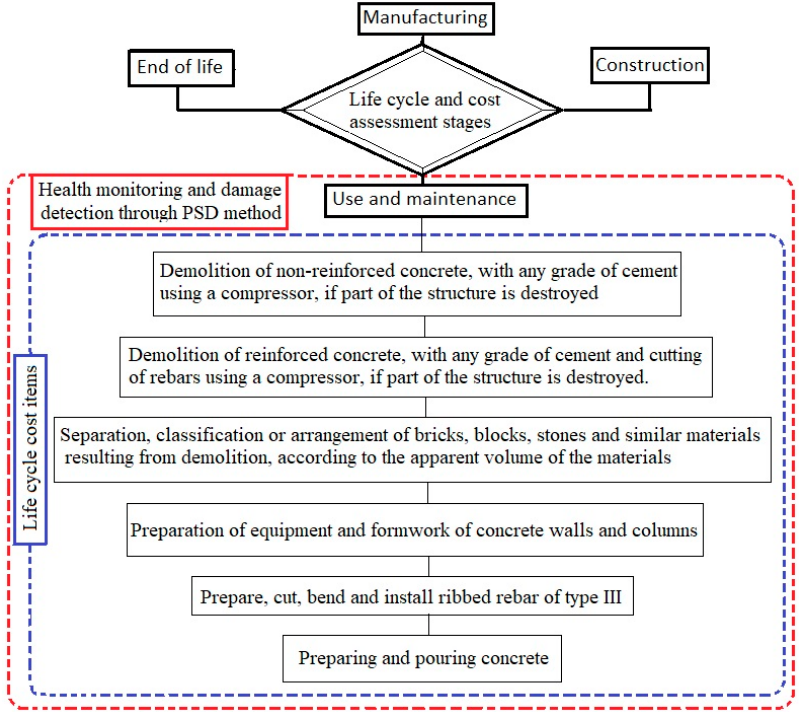
Figure 4. The LCCA using the PSD for maintenance and repair of the concrete bridge.